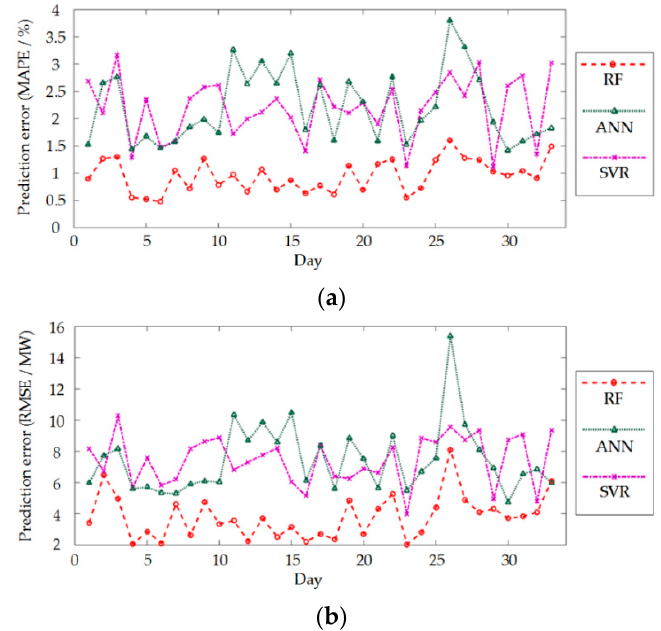
Figure 9. ( a ) MAPE of three predictors for each test day when 1 ‐ h ‐ ahead prediction is conducted; ( b ) RMSE of three predictors for each test day when 1 ‐ h ‐ ahead prediction is conducted.